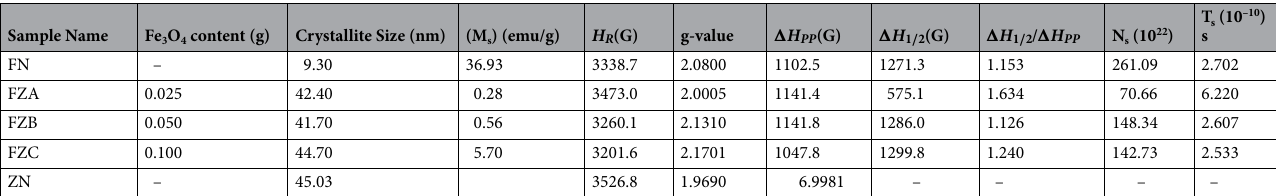
Table 1. Structural, magnetic and spin resonance parameters of ZN, FZNC and FN samples.